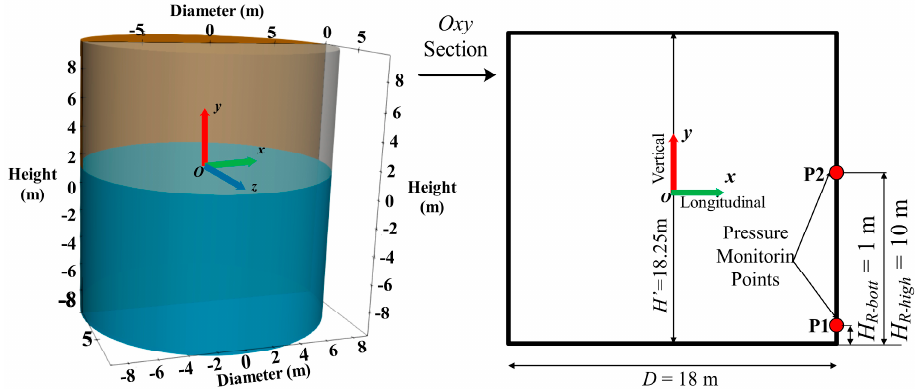
Figure 5. The geometry of the water storage tank.